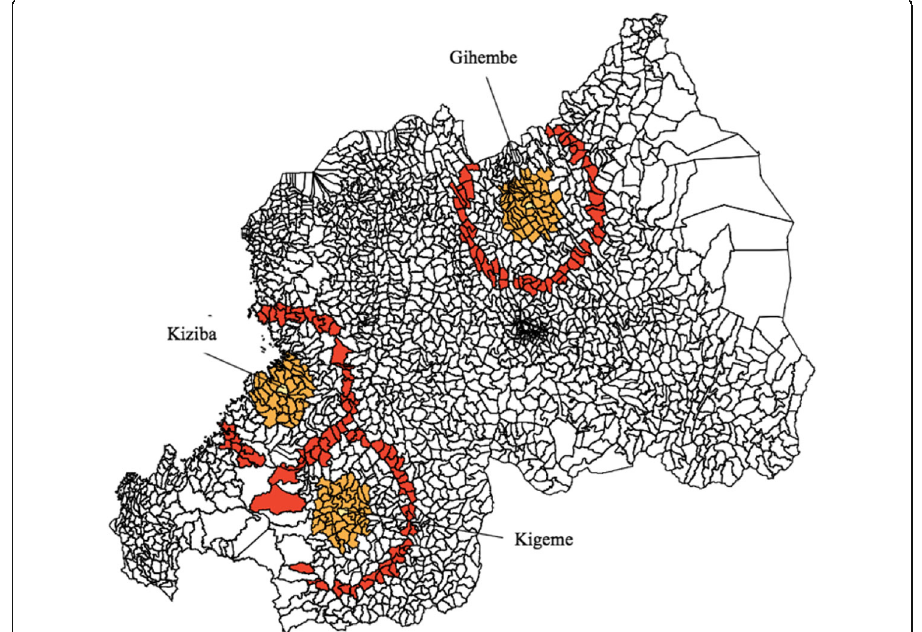
Fig. 2 Sampling strategy at the cell level. Legend: Note: Own generation based on publicly available administrative GIS data. Yellow cells indicate the location of each refugee camp. Orange cells are those within 10 km of each camp. Red cells are those above 20 km of each